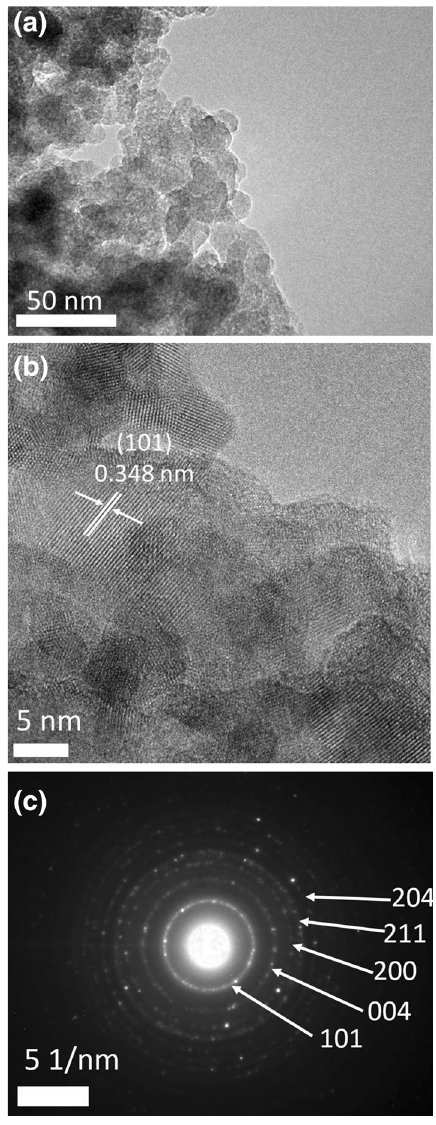
Figure 5. ( a ) TEM image of the prepared Co x Ni 1−x Fe 2 O 4 ; x = 0.9/SiO 2 /TiO 2 /C-dots nanocomposite; ( b ) HR-TEM image; (c) SAED